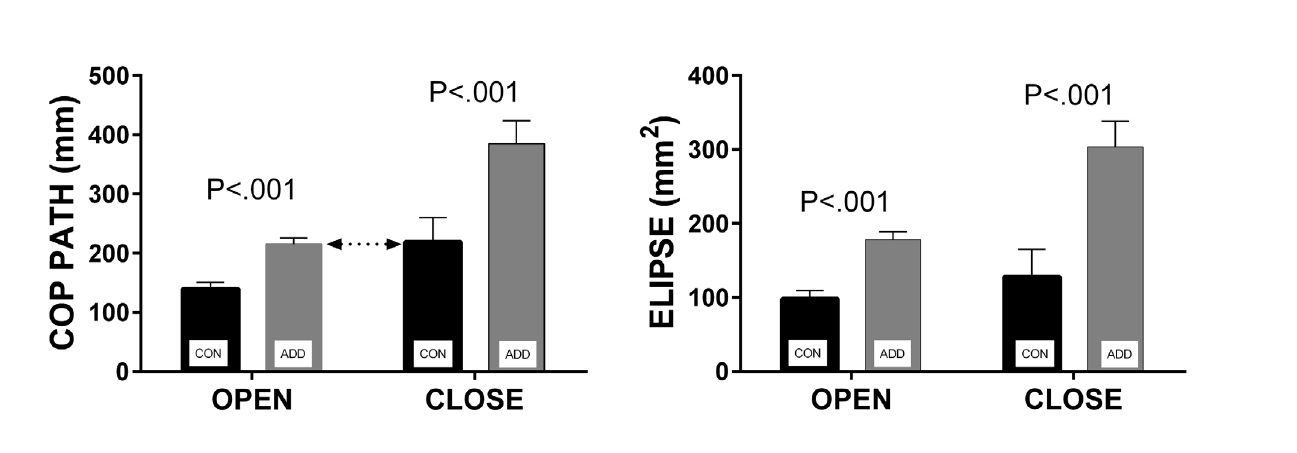
Figure 1. Body balance analysis in substance disorders group (SUD) and control group